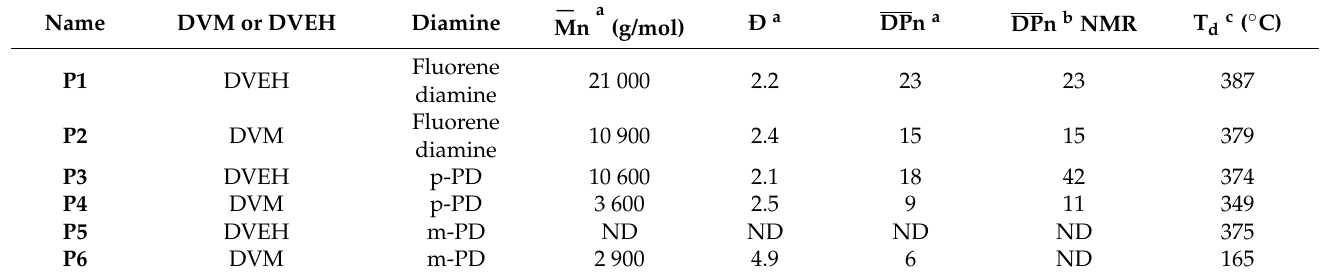
Figure 1. Recovery step performed on the crude fraction of P1 to increase the molar mass. (SEC in THF, R.I. detection). Table 1. Divanillin-based polyazomethines and their